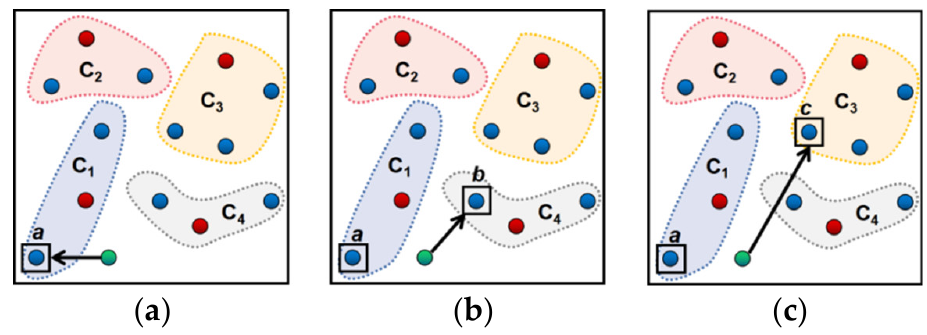
Figure 4. An example for Algorithm 3. ( a – c ) shows the searching process of points a , b, and c . Attraction Approach Vector